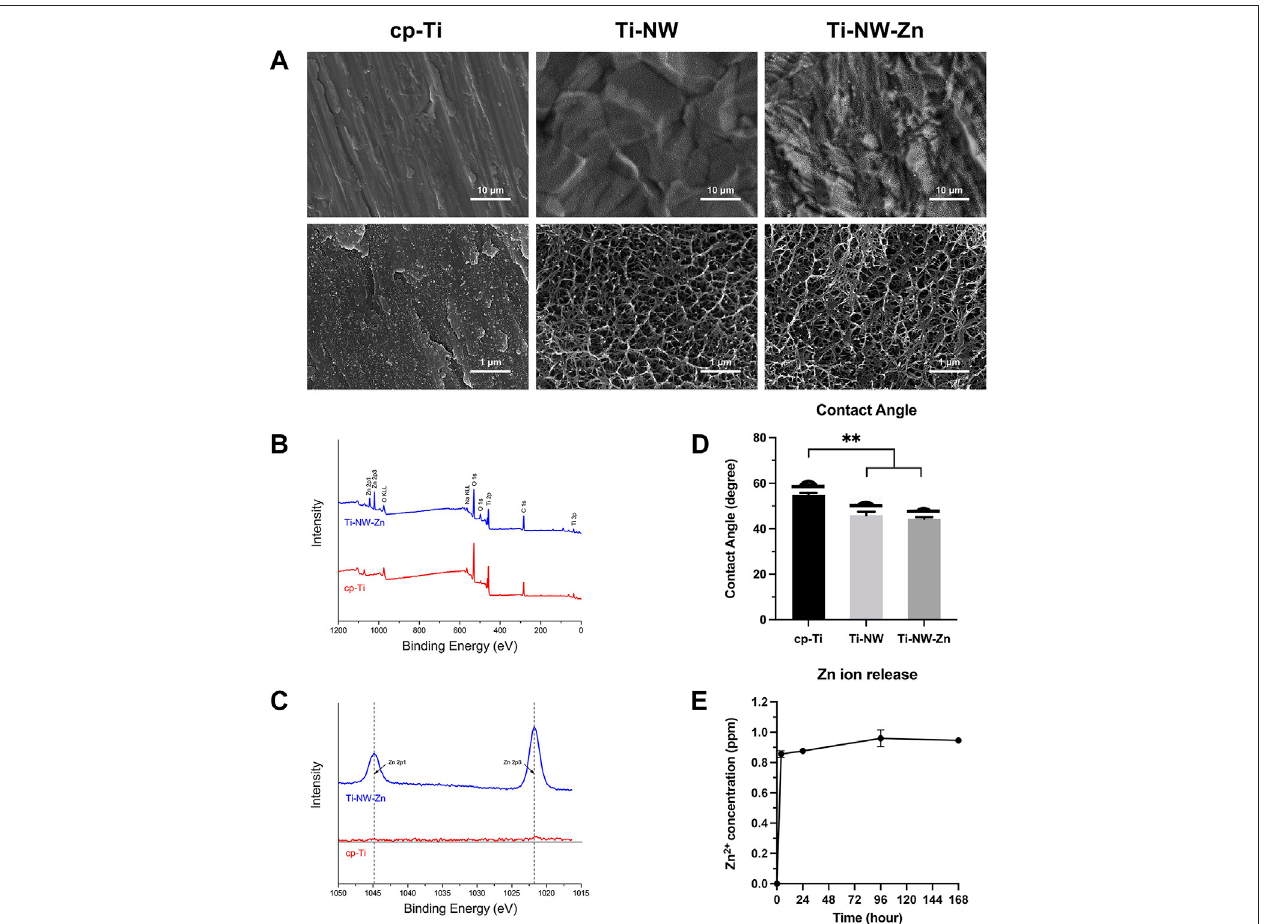
FIGURE 1 | Surface characterization of different titanium surfaces. (A) SEM images of surface morphologies of cp-Ti, Ti-NW, and Ti-NW-Zn. Upper panel: ×5000 magni fi cation. Lower panel: ×50000 magni fi cation; (B) XPS wide scan spectra analysis of cp-Ti and Ti-NW-Zn surfaces; (C) XPS high-resolution spectra analysis of Zn 2p; (D) contactanglesofcp-Ti,Ti-NW,andTi-NW-Znsurfaces.Resultswerepresentedasmean±SD(* p < 0.05,** p < 0.01;N=3); (E) concentrationsofZnionreleased from Ti-NW-Zn samples into PBS after 4 h and 1, 4, and 7 days; N =